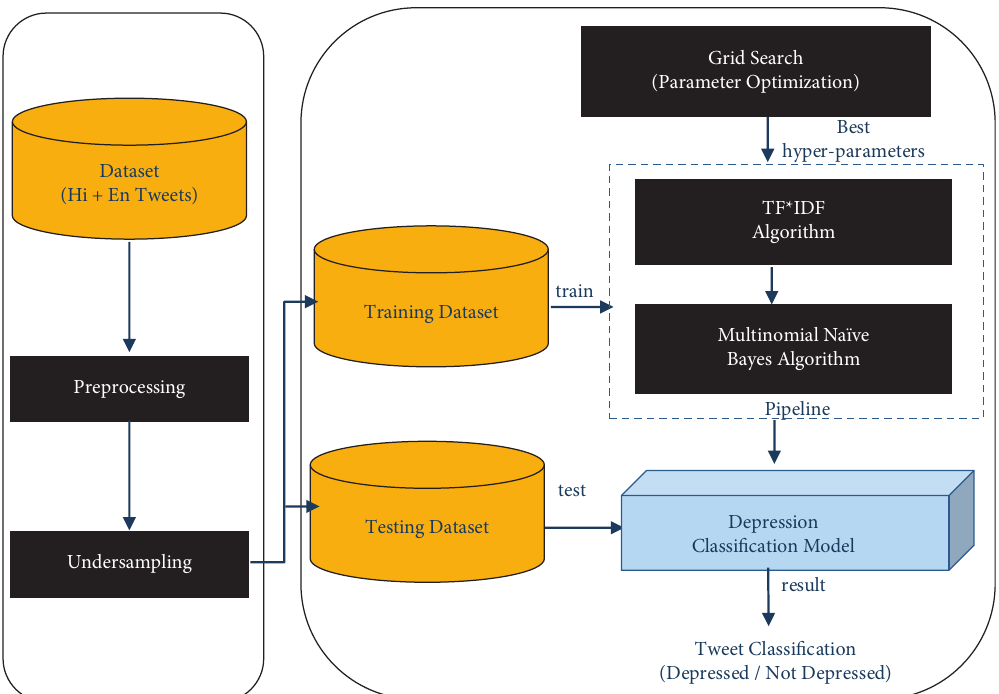
Figure 1: The model architecture of the depression classification system as a hybrid of MNB and grid